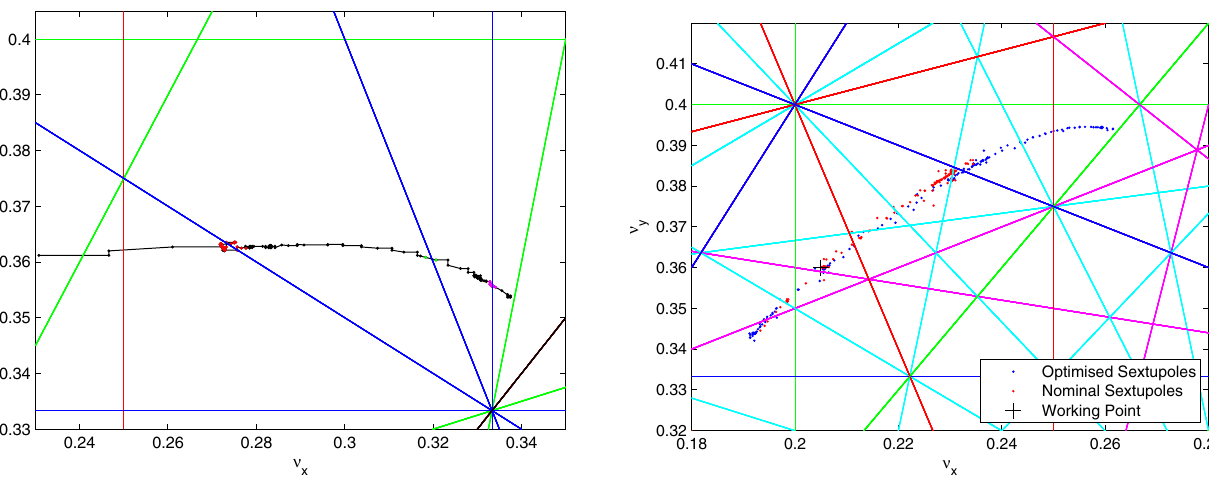
FIG. 11. Measured tune footprint before (red) and after (blue) the optimization of the